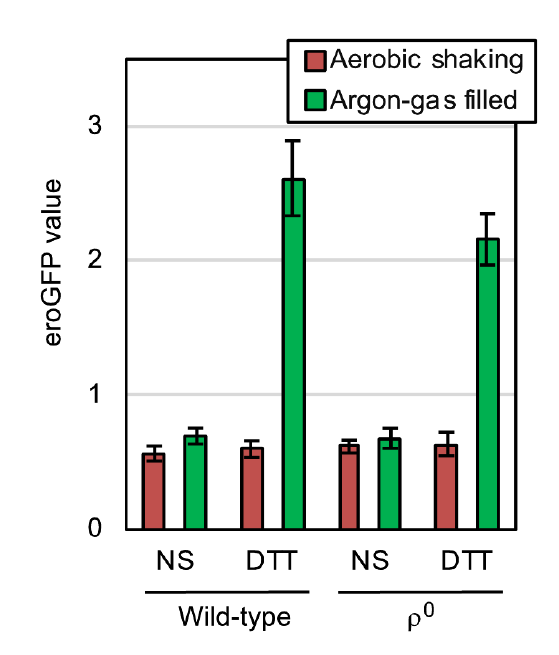
FIGURE 5: Hypoxic treatment potentiates ER stress-induced impairment of the cysteine disulfide bond-formation in the ER of both wild-type and  o mutant cells. At 30°C in YPD, wild-type BY4742 cells and the congenic  o mutant carrying the pPM28 eroGFP-expression plasmid were aerobically grown, and were stressed by 0.5 mM DTT (or remained non-stressed (NS)) under the aerobic shaking or argon gas-filled condition for 30 min. The cells were then fluorescence-microscopically observed using two different excitation lights for measurement of the eroGFP values, the calculation method of which is described in the Materials and Methods